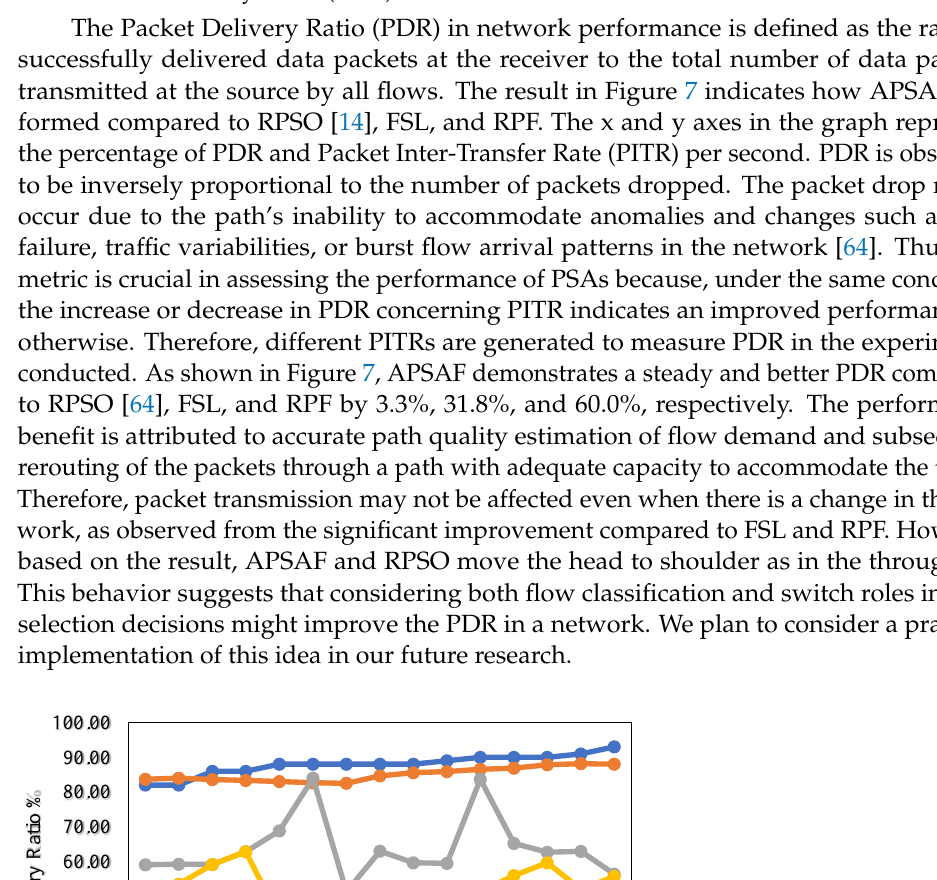
Figure 6. Throughput.